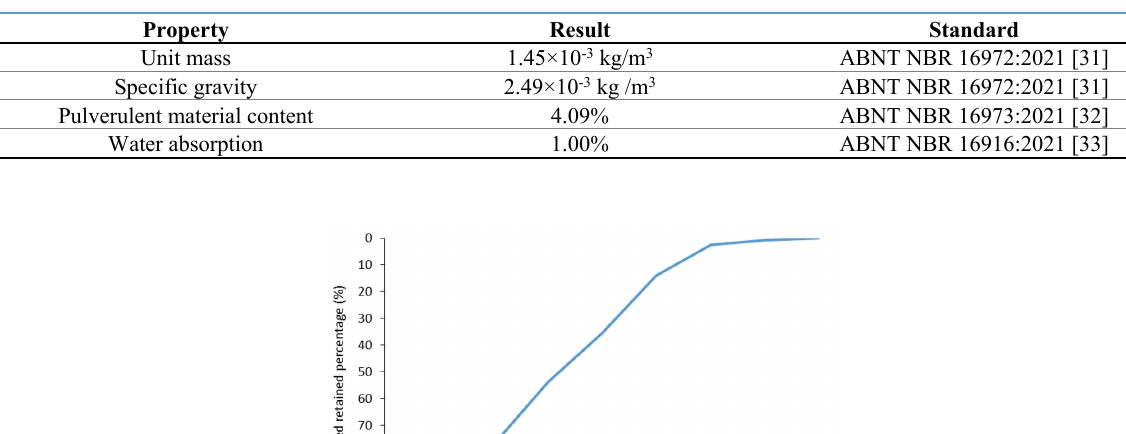
Table 1. Fine aggregate characterization